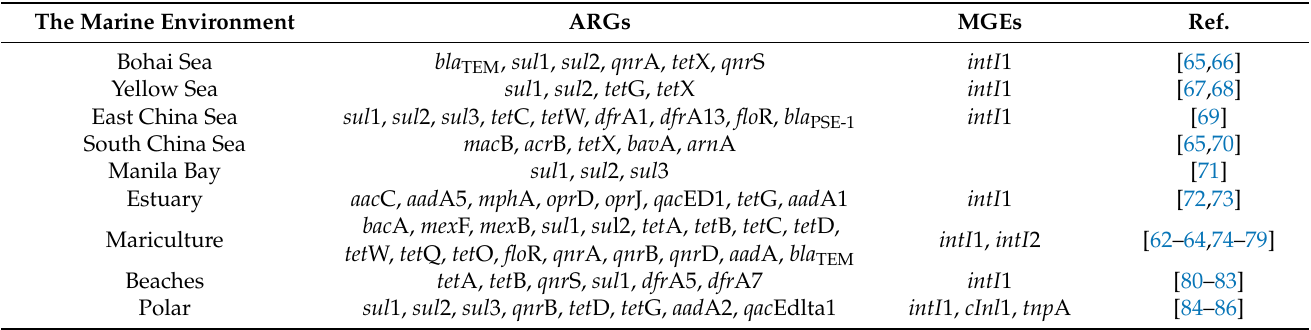
Table 3. Types and distribution of ARGs and MGEs in marine environments.